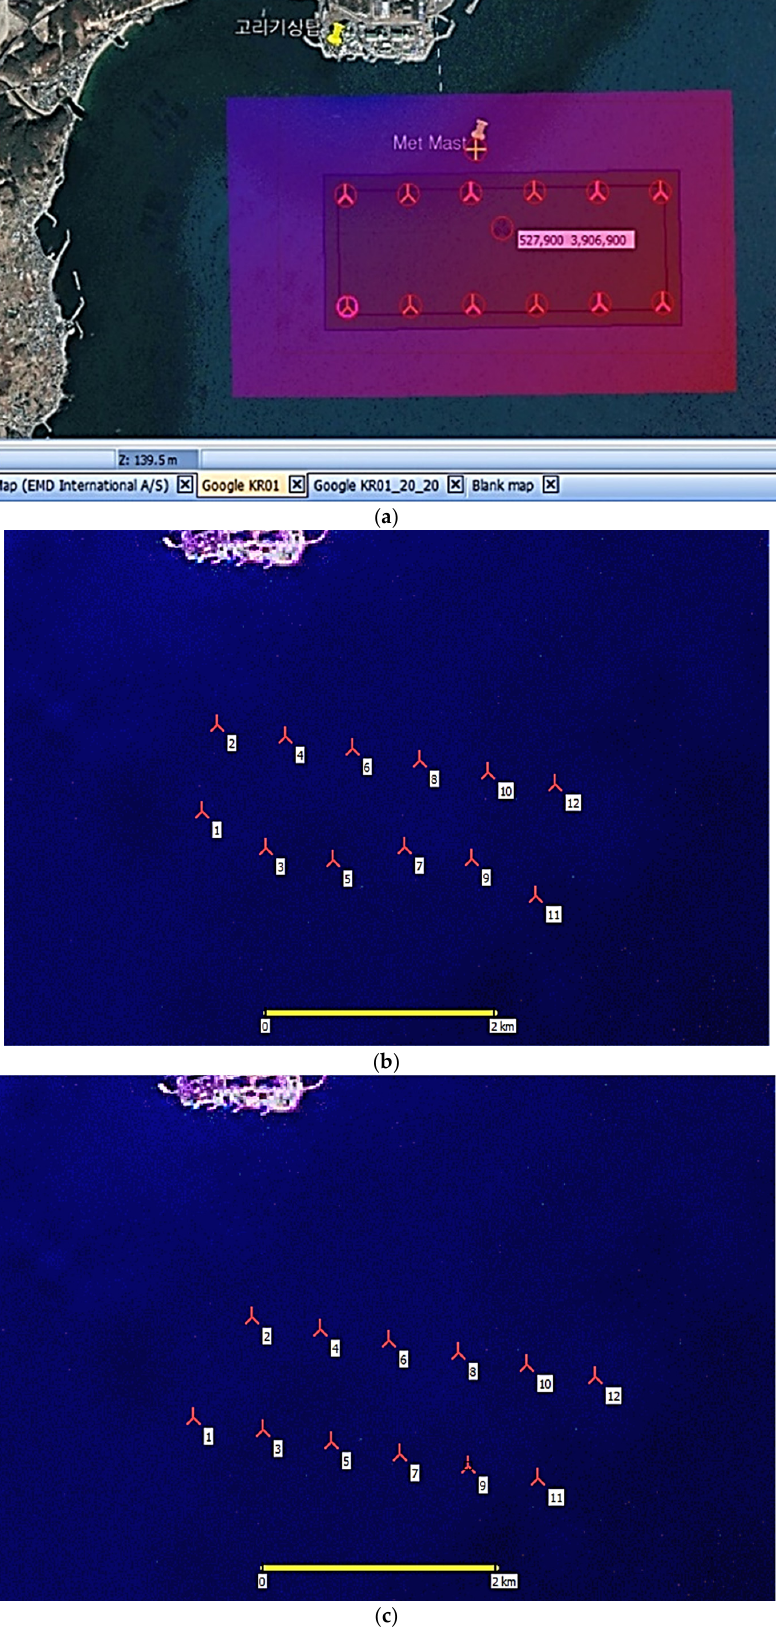
Figure 8. Optimal turbine layout for 12 WTGs (Wind Turbine Generators): ( a ) initial, ( b ) design of experiment (DOE) best solution ( c ) optimal